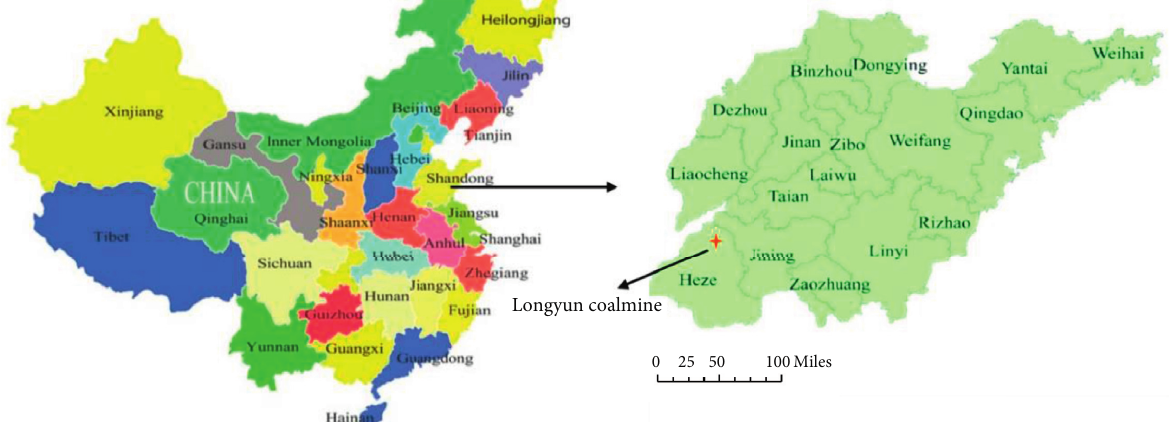
Figure 1: Location of Longyun coalmine in Shandong Province, China.